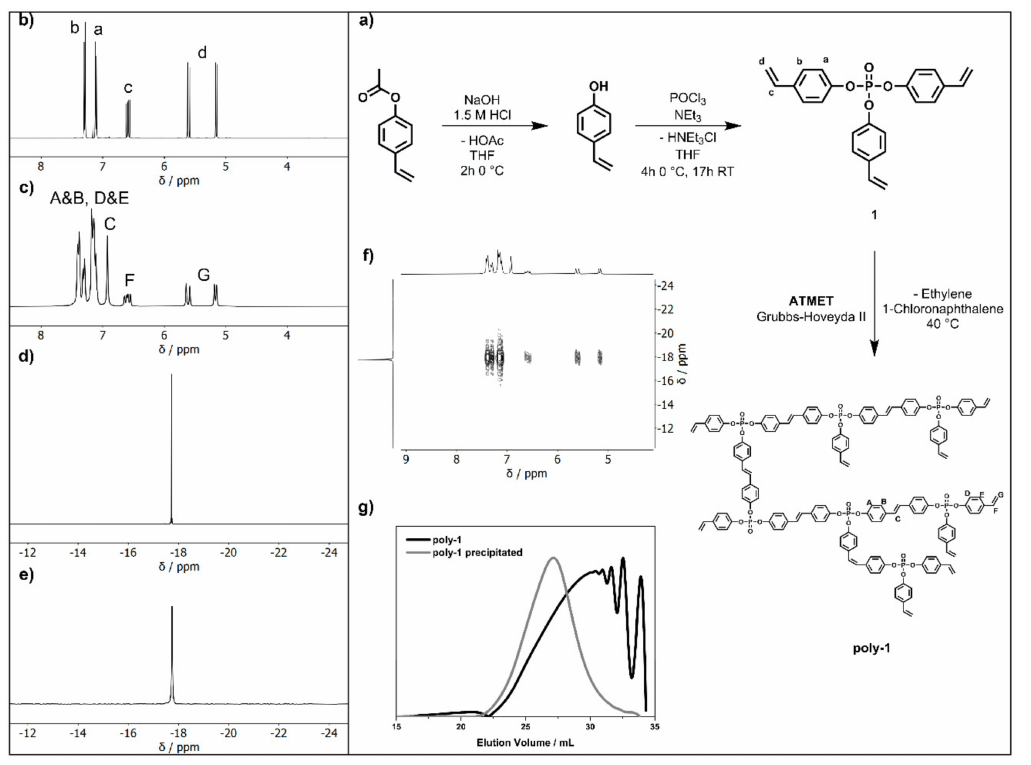
Figure 1. ( a ) Synthesis scheme of tris(p-vinylphenyl)phosphate (1) and poly(tris(p-vinylphenyl) phosphate) (hbPPE); ( b ) 1 H NMR spectra of 1; ( c ) 1 H NMR spectra of poly-1; ( d ) 31 P NMR spectra of